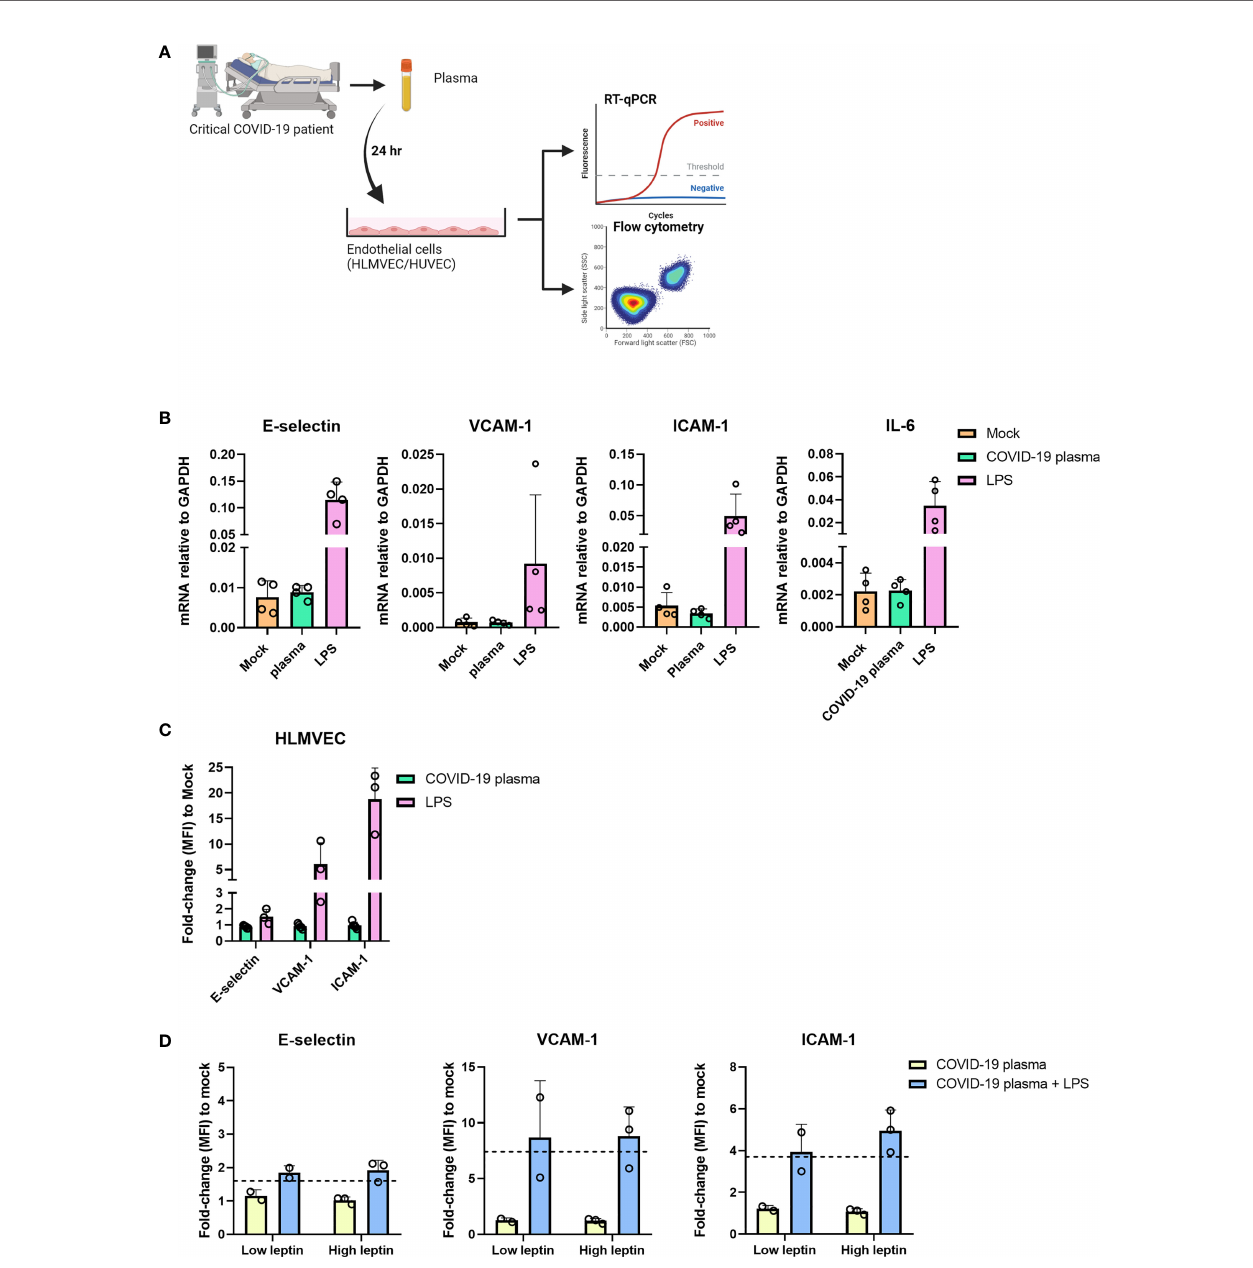
FIGURE 4 | Plasma from severe COVID-19 patients does not activate HLMVEC. (A) schematic overview of the experimental set-up. HLMVEC were incubated with 30% plasma from critically ill COVID-19 patients or stimulated with LPS 1 µg/mL for 24 hr. (B) The mRNA levels of E-selectin, VCAM-1, ICAM-1, and IL-6 were determined by RT-qPCR. Results are expressed as the mean ± SD of 4 individual experiments with duplicate technical replicates (C) Protein levels of E-selectin, VCAM-1 and ICAM-1 were determined by fl owcytometry, data is represented as MFI fold-change to mock and represented as mean ± SD of at least three independent experiments. (D) HUVECs were incubated with critically ill COVID-19 patient plasma containing high leptin concentrations n=3 donors (average 77,3 ng/ mL) or low leptin concentrations n=2 donors (average 2,3 ng/mL) and supplemented with or without LPS 1 ug/mL for 4 hr. Protein levels of E-selectin, VCAM-1 and ICAM-1 were determined by fl ow cytometry, data is represented as the MFI fold-change to mock and represented as mean ± SD. Dotted line indicates fold change to mock of only LPS stimulated cells for 4 hr. Each symbol represents data from a single independent experiment. Student T test was used to evaluate statistical differences and a p value ≤ 0.05 was considered signi fi cant with *p ≤ 0.05, **p ≤ 0.01 and ***p ≤ 0.001. In the absence of ‘ * ’ the data is non-signi fi cant. Figure 4A was created with